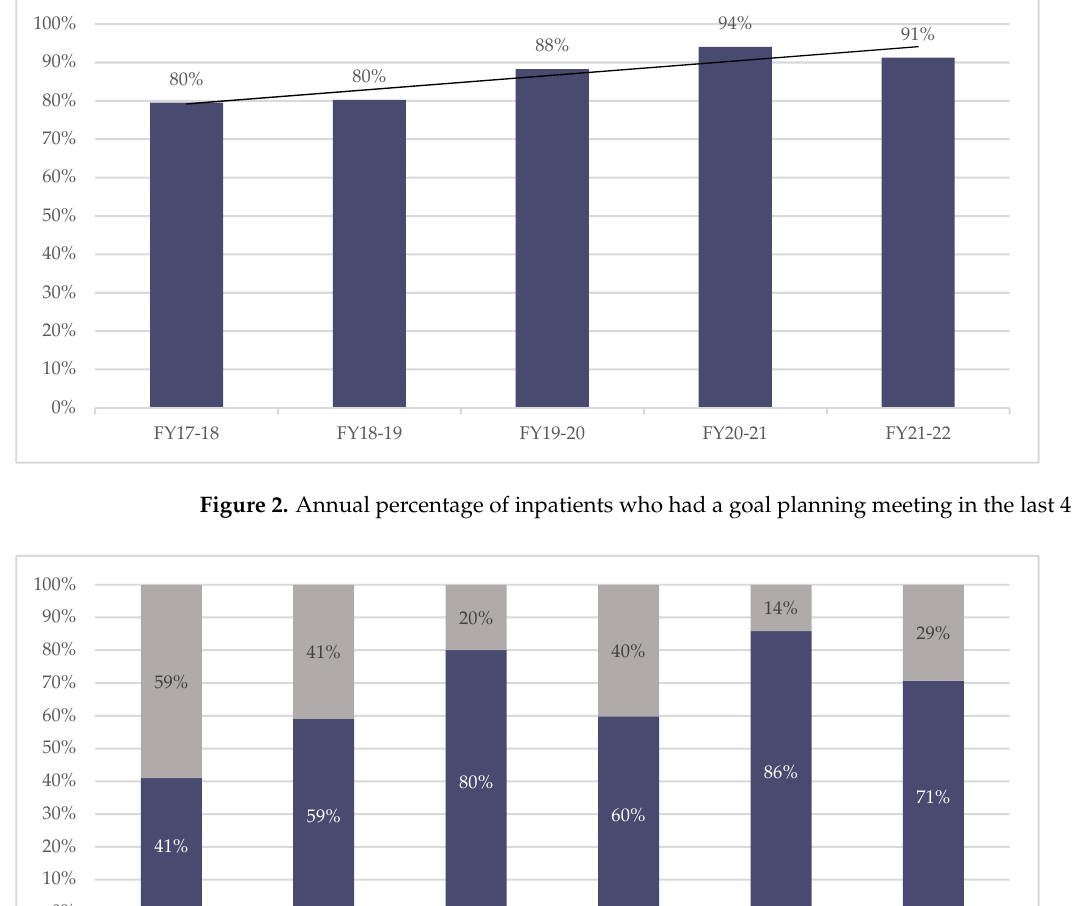
Figure 3. Annual percentage of SMS-NACs completed <2 weeks and >2 weeks from inpatient mo- bilisation.